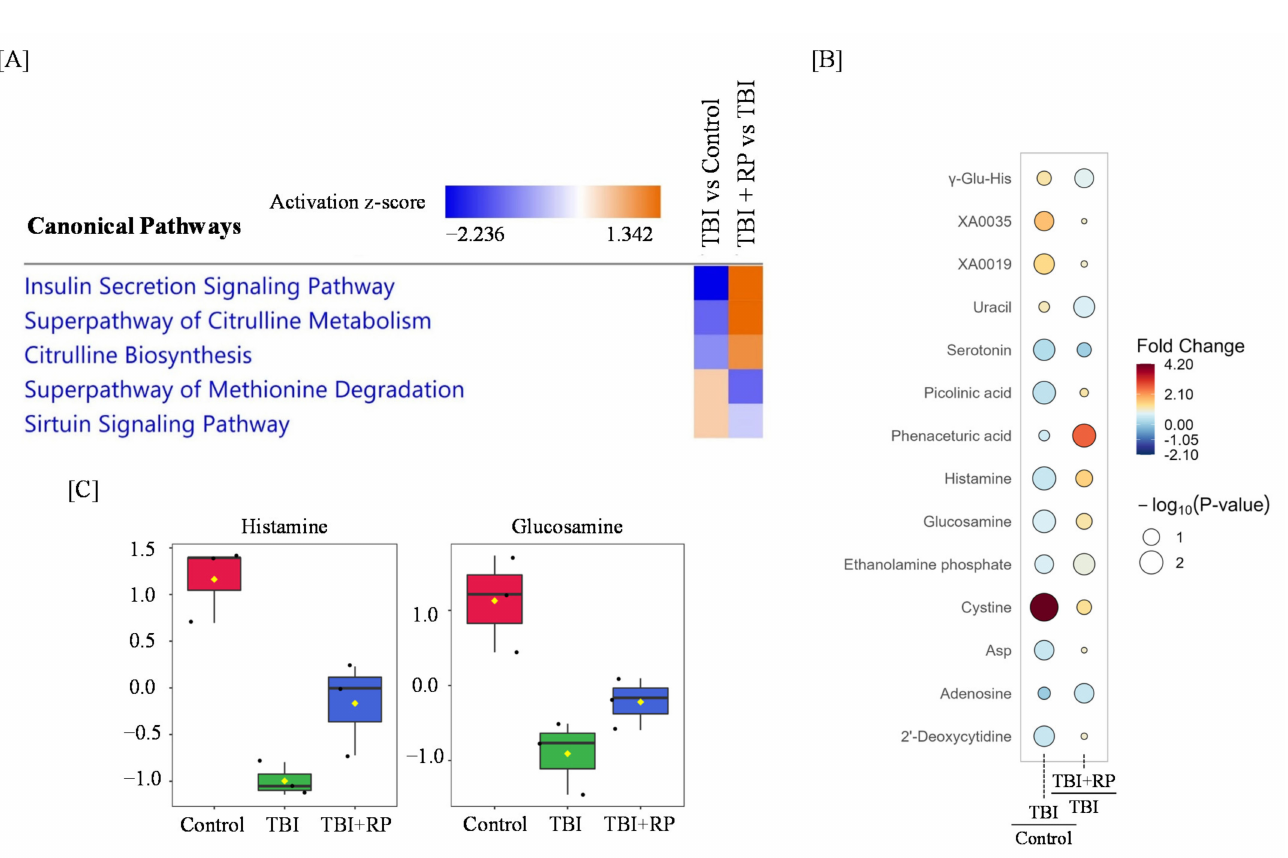
Figure 4. Radiomitigative effects of RP on the disruption of metabolome profiling and pathway by TBI. ( A ) An IPA analysis of the top canonical pathways in TBI and TBI + RP is represented. Colors indicate higher or lower Z scores. ( B ) Raindrop illustration of metabolite patterns showed fold changes between TBI and control or TBI + RP and TBI. The scale bar represents the normalized intensity of metabolites, where blue indicates a decrease/low and red indicates an increase/high. The size of the drop represents the − log 10 ( p -value); Asp—Aspartate. ( C ) Boxplots of metabolite were presented. The black dots represent the normalized value of metabolite. The notch indicates 95% confidence interval around the